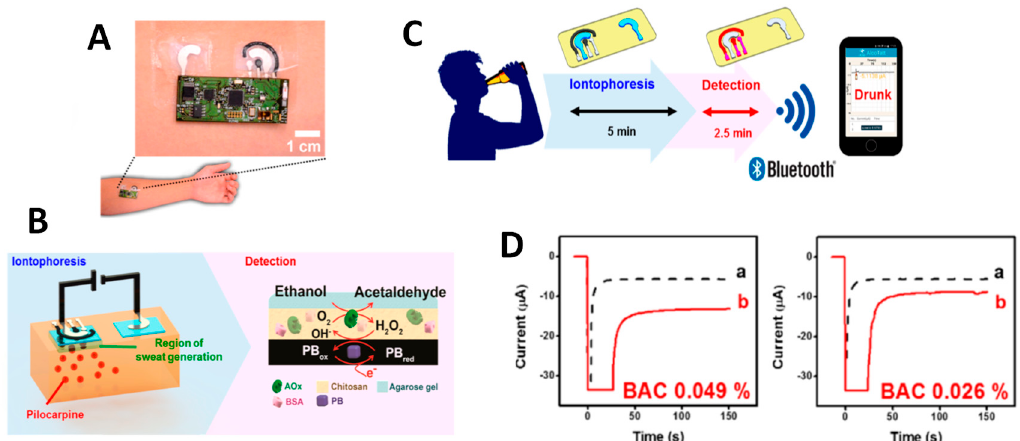
Figure 2. Alcohol iontophoretic-sensing tattoo device with integrated flexible electronics applied to a human patient ( A ); schematic diagram of constituents in the iontophoretic system (left) and processes involved in the amperometric sensing of ethanol (right) ( B ); scheme of the wireless operation for transdermal alcohol sensing ( C ); amperograms recorded before (a) and after (b) drinking alcohol beverage ( D ). BAC (blood alcohol concentration) recorded by a breath analyzer. Potential step to − 0.2 V vs. Ag/AgCl. Reprinted from [38], with permission.